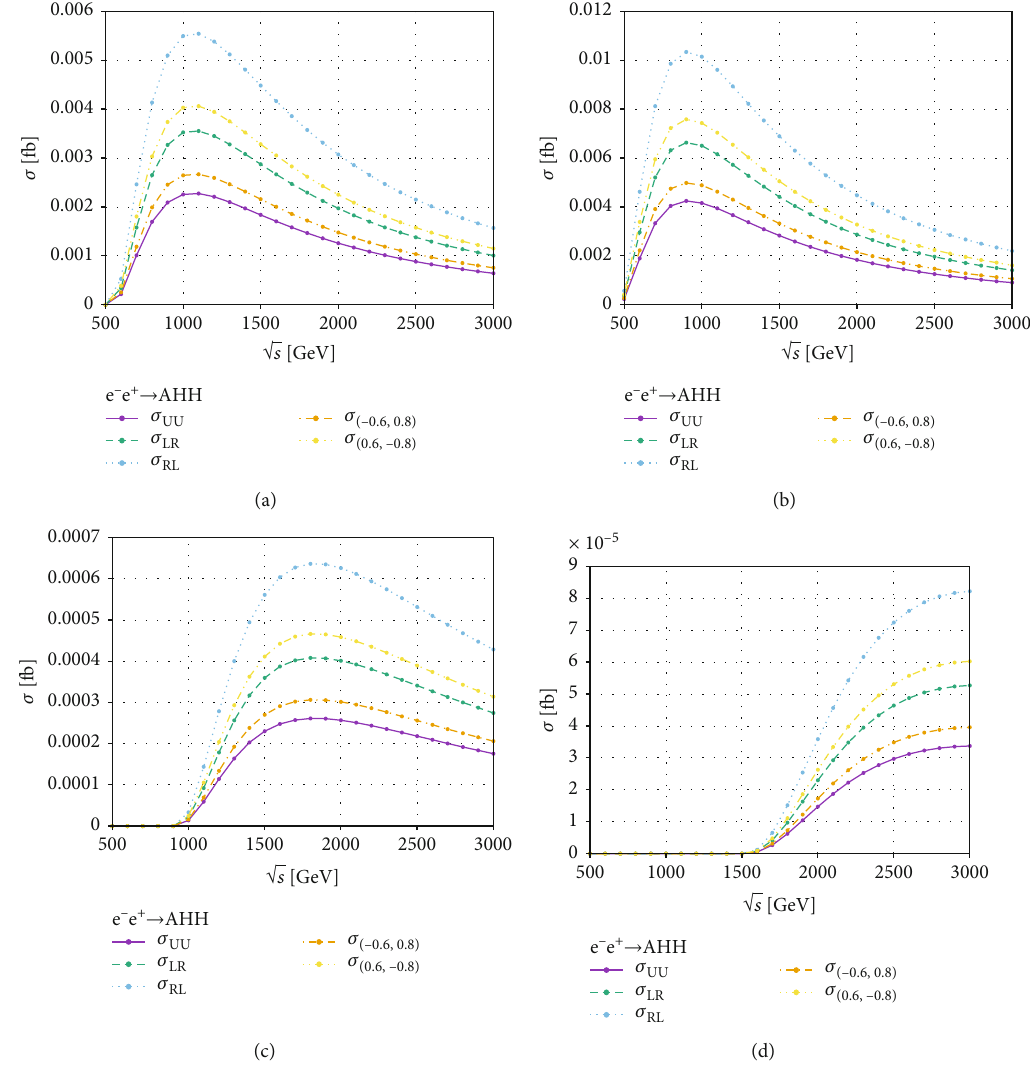
ffiffi p ( GeV ) in 2HDM is displayed in above fi gures, while the Higgs mass s